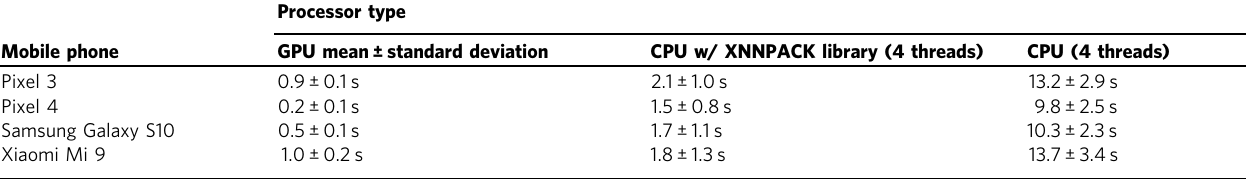
Table 3 Mobile-device model run-time